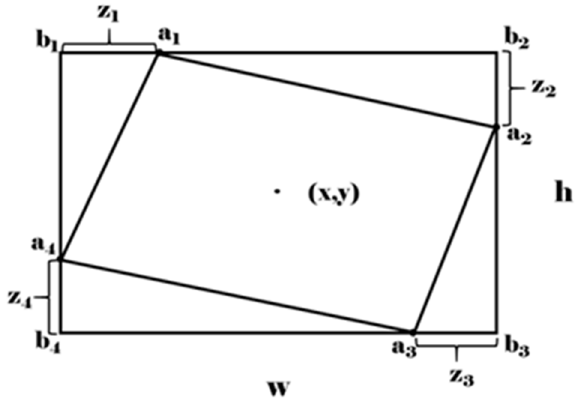
Figure 3. Schematic diagram of the sliding vertex box definition method.